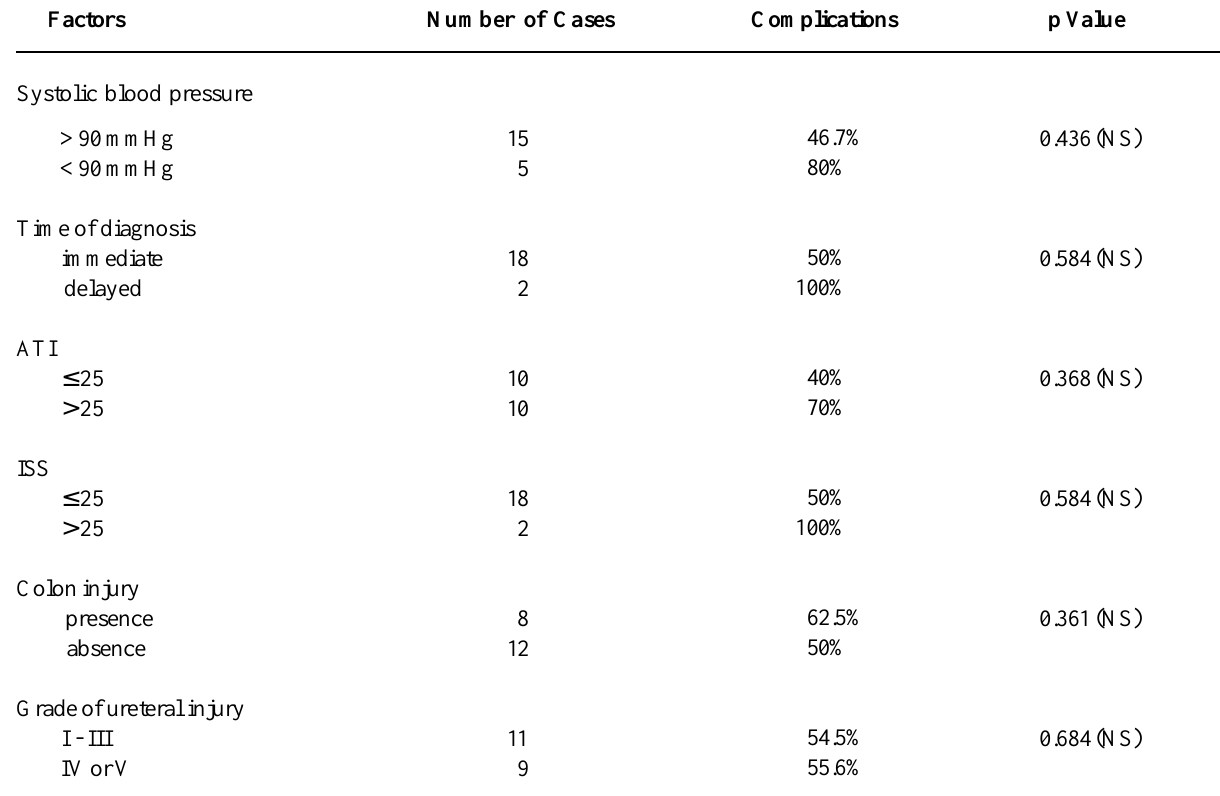
Table 4 – Relationship between different factors and outcome of patients.